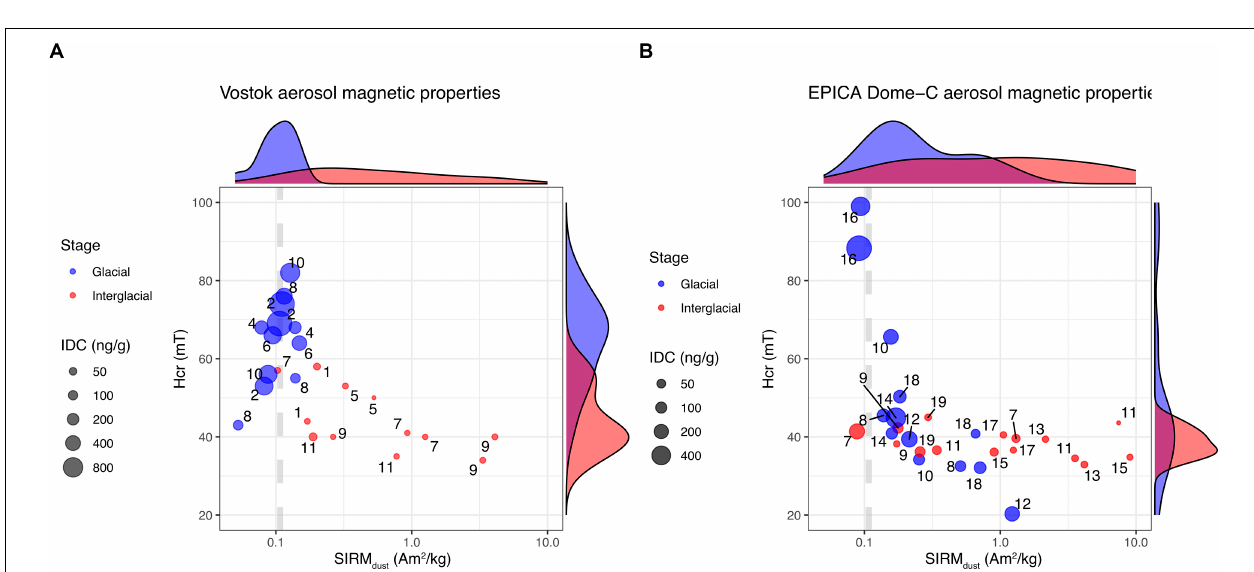
FIGURE 5 | Semi-logaritmic SIRM/H cr diagram. Samples are grouped by color in glacial and interglacial stages with numbers indicating the isotopic stage (MIS) of each sample, symbols size are proportional to IDC. Vertical line at 0.11 A m 2 /kg represents the average SIRM dust computed by the best-fit line. (A) The magnetic properties of VK are distributed along the vertical line of constant SIRM. Some low IDC samples from interglacial stages 5, 7, 9, and 11 plot in the lower-right part of the SIRM/H cr diagram. (B) Only two EDC samples from MIS 16 exhibit true glacial magnetic properties and plots in the upper-left portion of the SIRM/H cr diagram. Most samples are characterized by low H cr and high SIRM irrespective of climatic stage. Note, however, that no EDC samples prior to MIS 6 are present in this